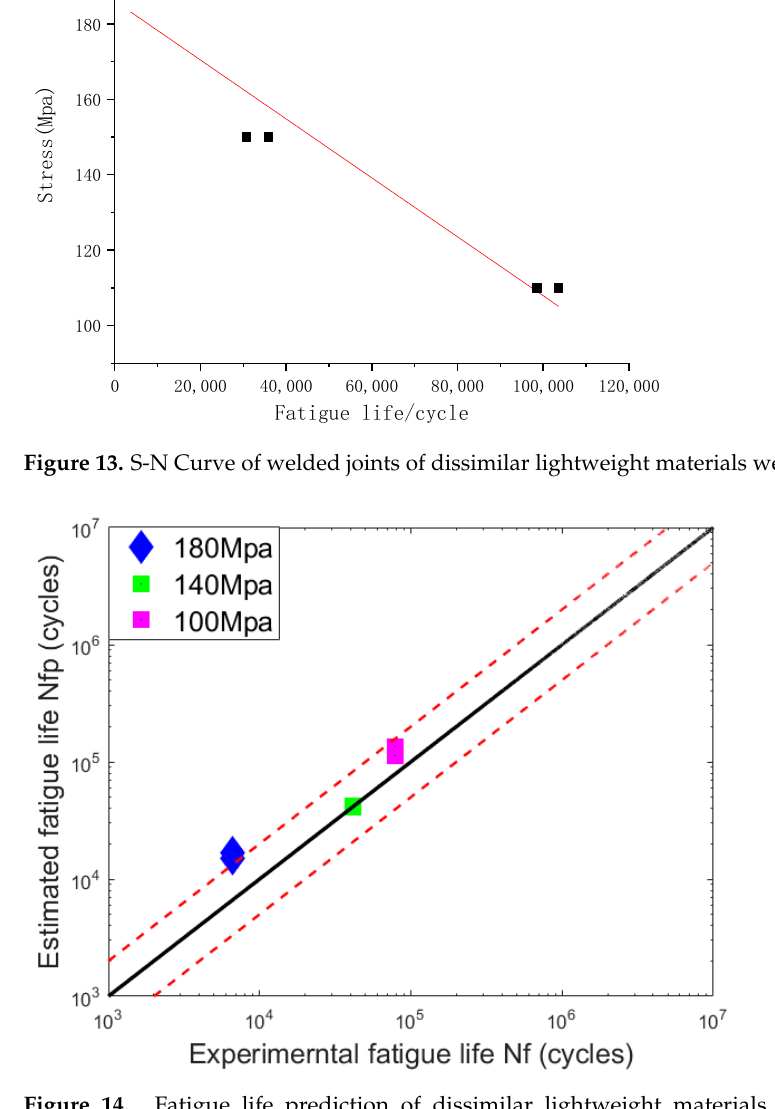
Figure 14. Fatigue life prediction of dissimilar lightweight materials weld joints from S-N curve method.